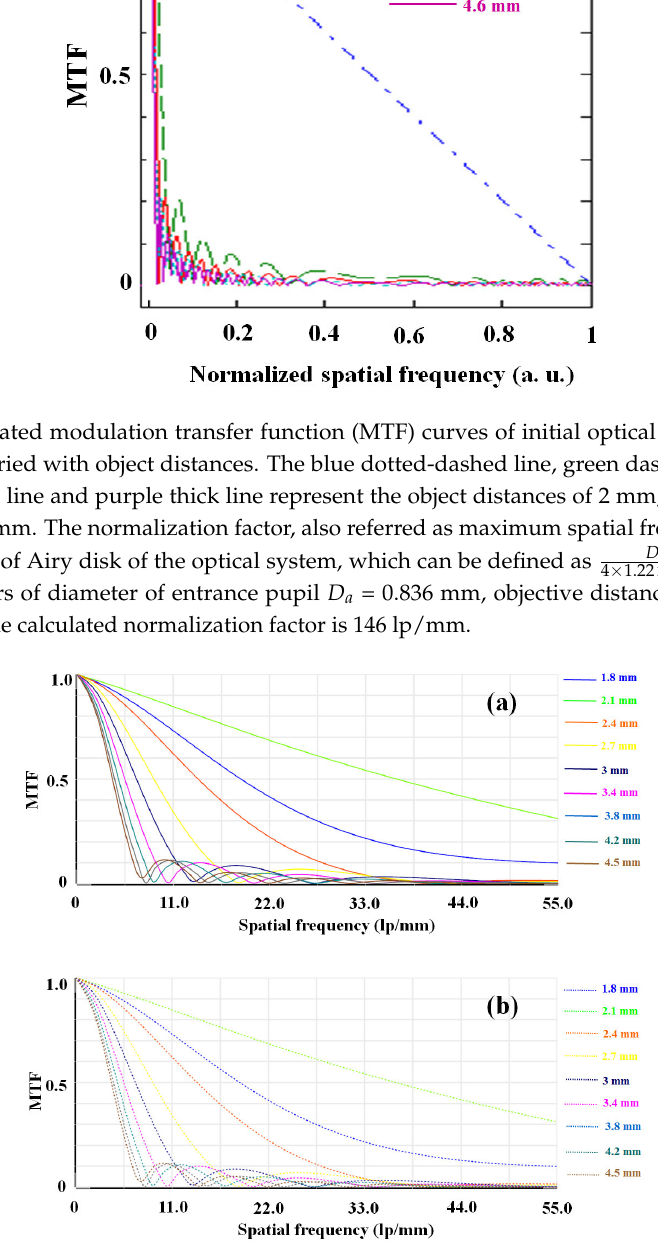
Figure 3. Simulated MTF curves of initial optical endoscope varied with object distances. ( a ) Tangential direction. ( b ) Sagittal direction. The blue line, green line, orange line, yellow line, mazarine line, purple line, cyan line, aquamarine line and gray line represent the object distances of 1.8 mm, 2.1 mm, 2.4 mm, 2.7 mm, 3 mm, 3.4 mm, 3.8 mm, 4.2 mm and 4.5 mm,